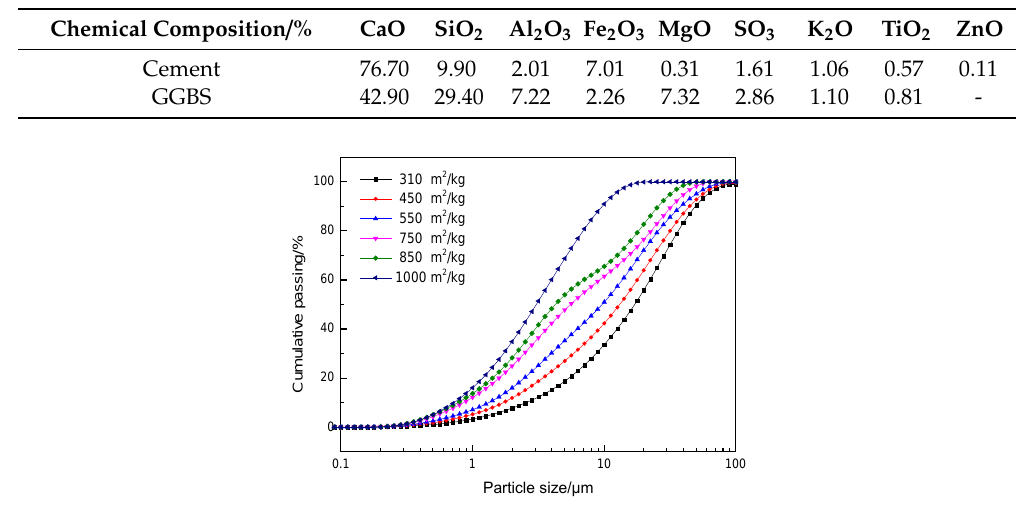
Figure 1. Particle size distribution curves of ground granulated blast furnace slag (GGBS).